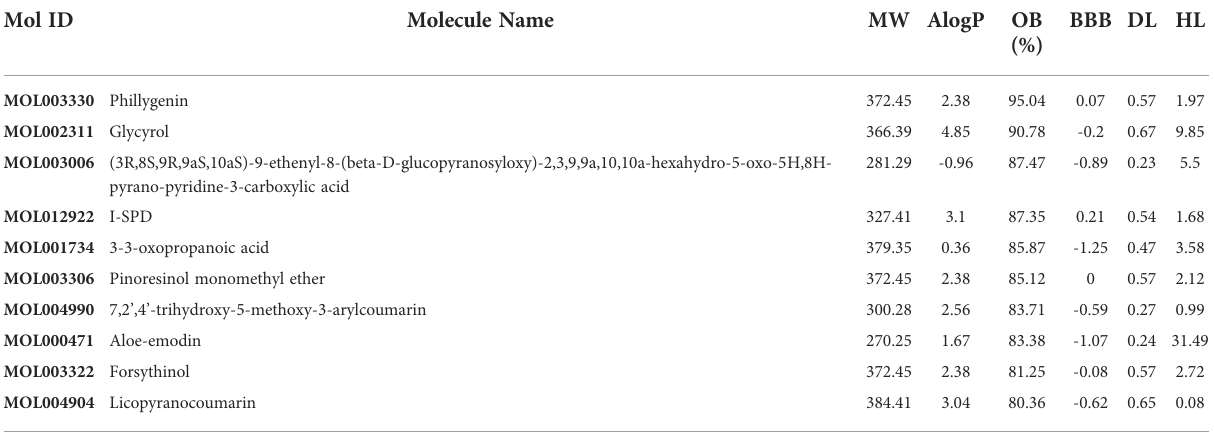
TABLE 1 The active ingredients in Lianhua Qingwen granules (LHQW). The active ingredients in Lianhua Qingwen granules (LHQW) Mol